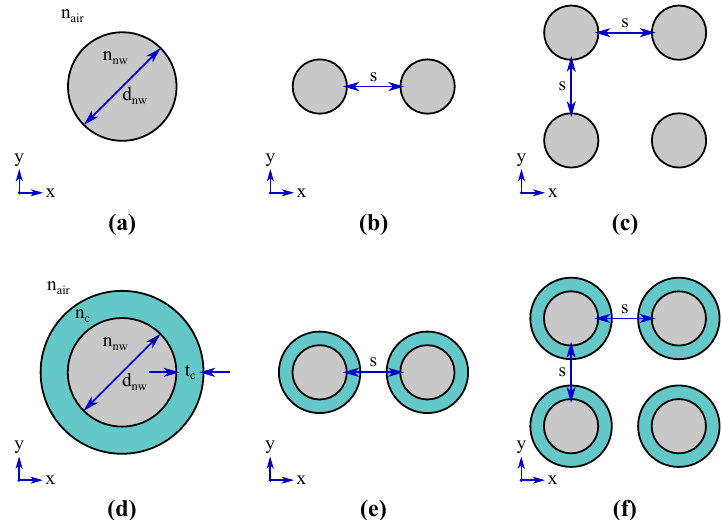
Figure 1. Nanowire oligomer waveguide xy -plane cross-sections. ( a ) monomer; ( b ) dimer; ( c ) tetramer; ( d ) coated monomer; ( e ) coated dimer; ( f ) coated tetramer. The nanowire diameter d nw , coating thickness t c , nanowire separation s , and refractive indices n nw , n c , and n air = 1 are also